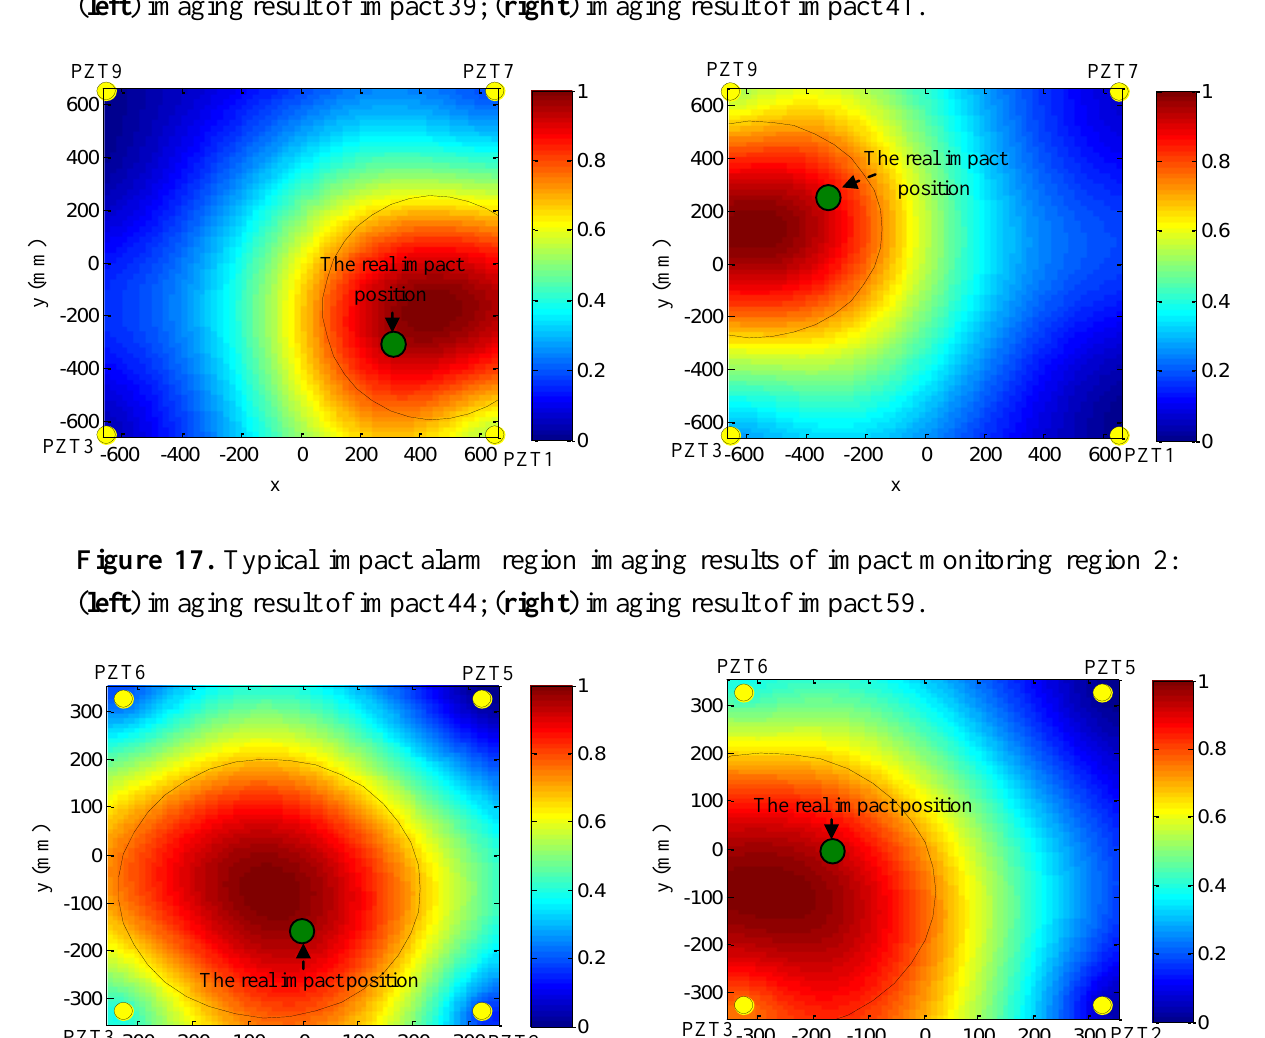
Figure 16. Typical impact alarm region imaging results of impact monitoring region 1: ( left ) imaging result of impact 39; ( right ) imaging result of impact 41.